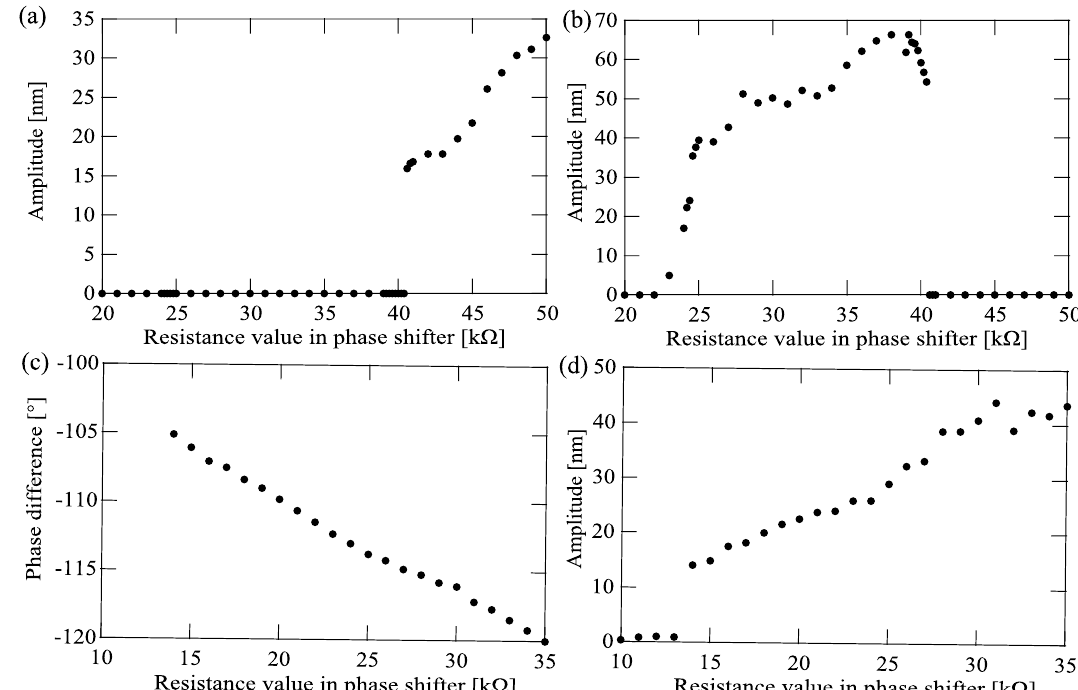
Figure 12. ( a , b ) show the amplitude magnitude changes in the cases when the base step and the microcantilever are self-excited in air, respectively, while the resistance value in the phase shifter is varied. ( c , d ) show change in the phase difference and the amplitude magnitude, respectively, caused by phase modulation under application of a 400 µ N pressing load while the resistance value in the phase shifter was varied from 10 k (cid:31) to 35 k (cid:31)